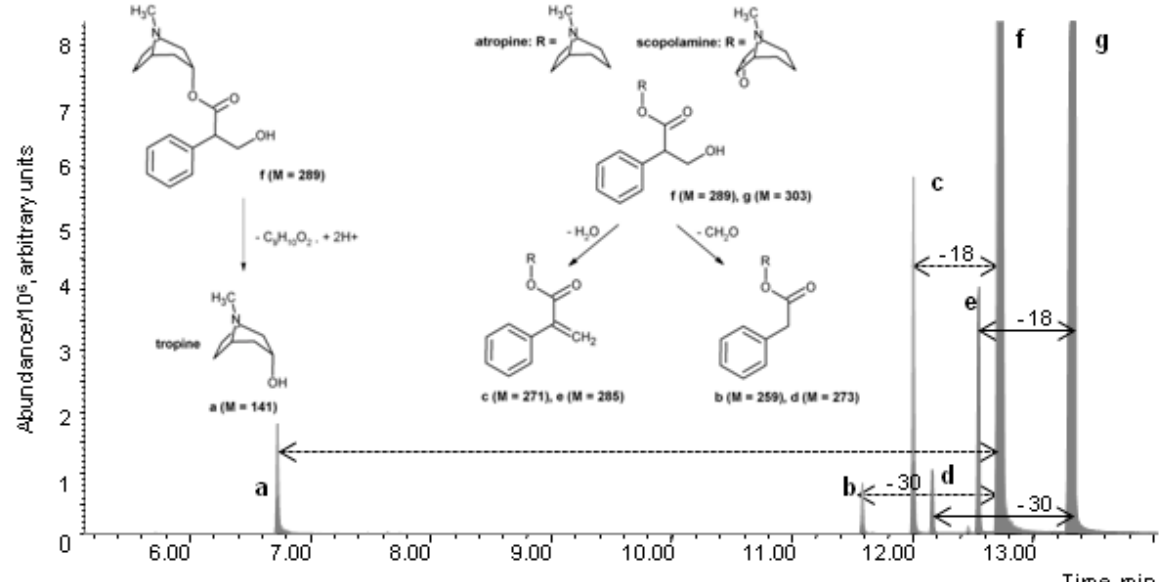
Figure 2. GC-MS chromatogram of atropine, scopolamine, and their thermolysis products with a tropane skeleton, obtained by extraction and merging of two ion currents ( m / z 124–atropine related and m / z 94–scopolamine related) from TIC. The elimination of water ( ∆ M : − 18) and formaldehyde ( ∆ M : − 30) was observed in both tropanes while a significant cleavage of ester bond was seen only in atropine. The inlet temperature was 250 ◦ C. Tropine ( a ), 3-phenylacetoxytropane (atropine-CH 2 O) ( b ), apoatropine (atropine-H 2 O) ( c ), 3-phenylacetoxyscopine (scopolamine-CH 2 O) ( d ), aposcopolamine (scopolamine-H 2 O) ( e ), atropine ( f ), and scopolamine ( g ).